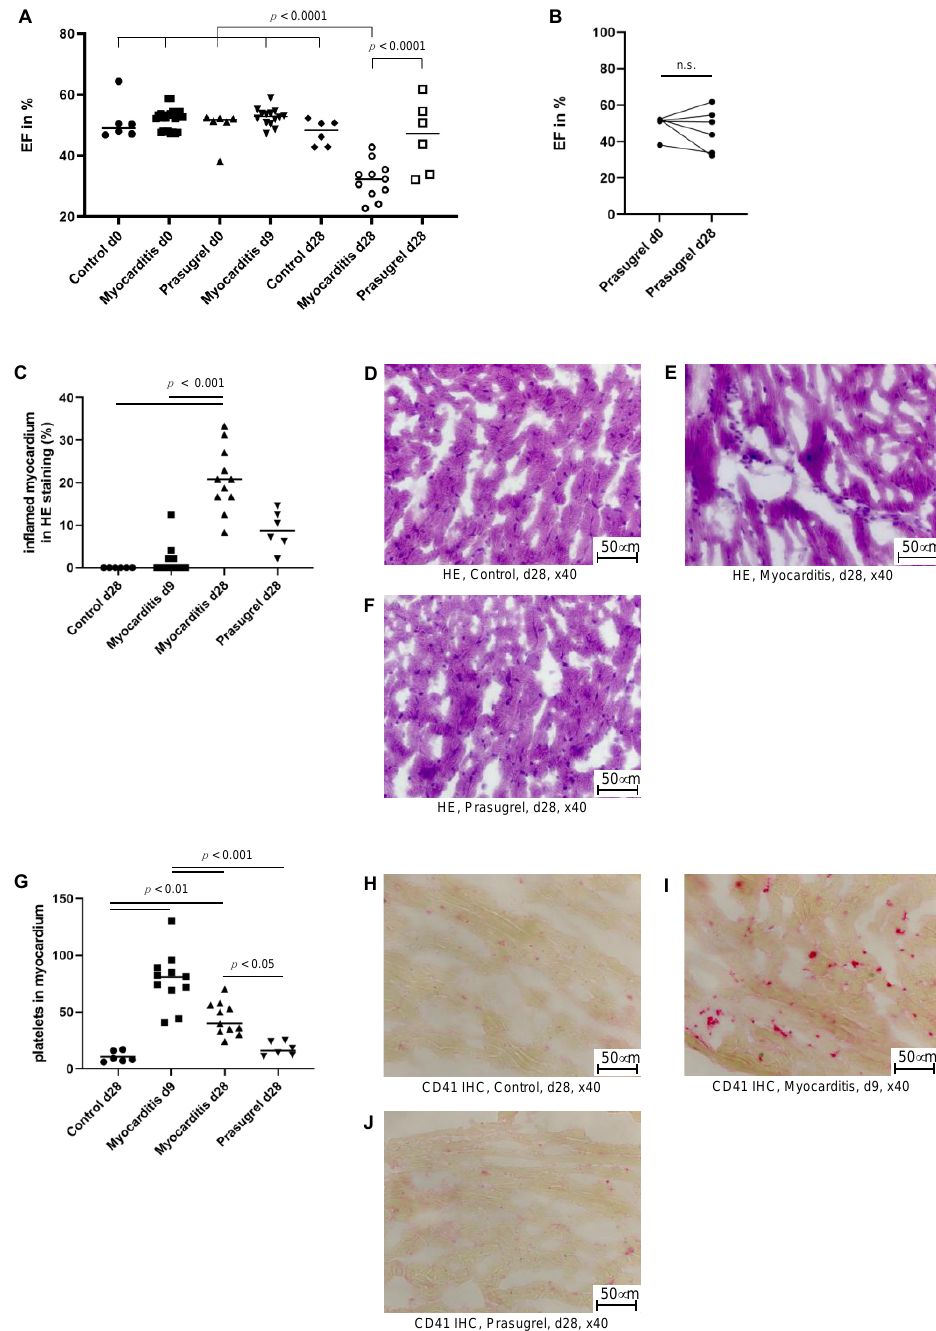
Figure 3. Platelets occur before inflammatory infiltrates and heart failure; P 2 Y12 receptor inhibition with prasugrel limits heart failure and platelet aggregation in the myocardium in murine myocarditis. ( A ) Comparison of the ejection fractions of mice with myocarditis ( n = 11), mice without myocarditis ( n = 6), and prasugrel therapy mice ( n = 6). On day 28, a significantly improved ejection fraction of the prasugrel therapy group was seen (ordinary one-way ANOVA). ( B ) Paired observation of the ejection fractions of myocarditis mice with simultaneous oral prasugrel therapy ( n = 6) shows a mean ejection fraction on day 28 similar to the baseline level (Wilcoxon test, two-tailed, paired, n.s. (not significant)). At the same time, a widespread distribution is evident with some mice preserving their ejection fraction and some mice deteriorating to the level of myocarditis mice without